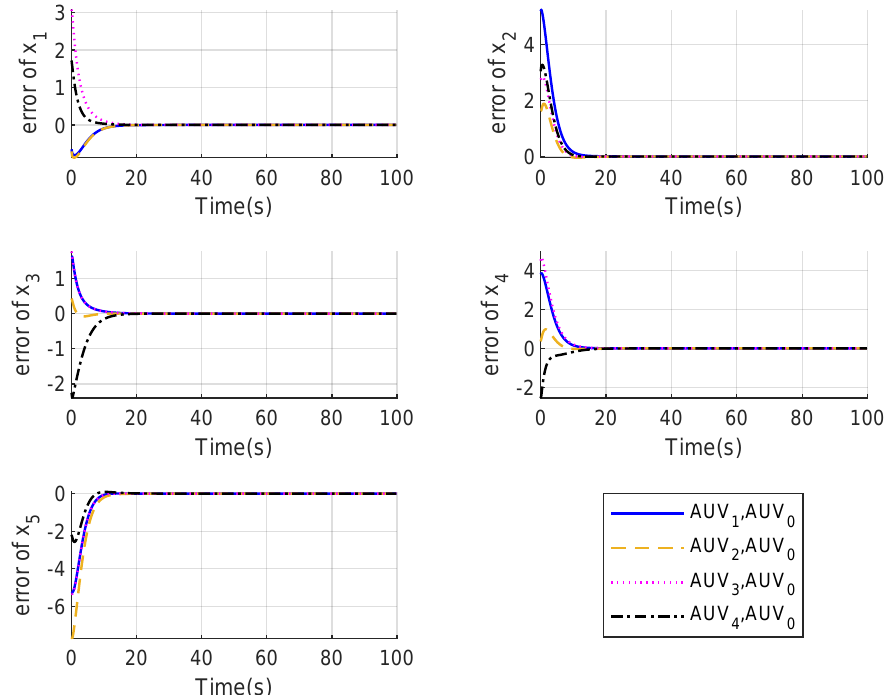
Figure 3. Errors of position state under ideal communication topology without delay.